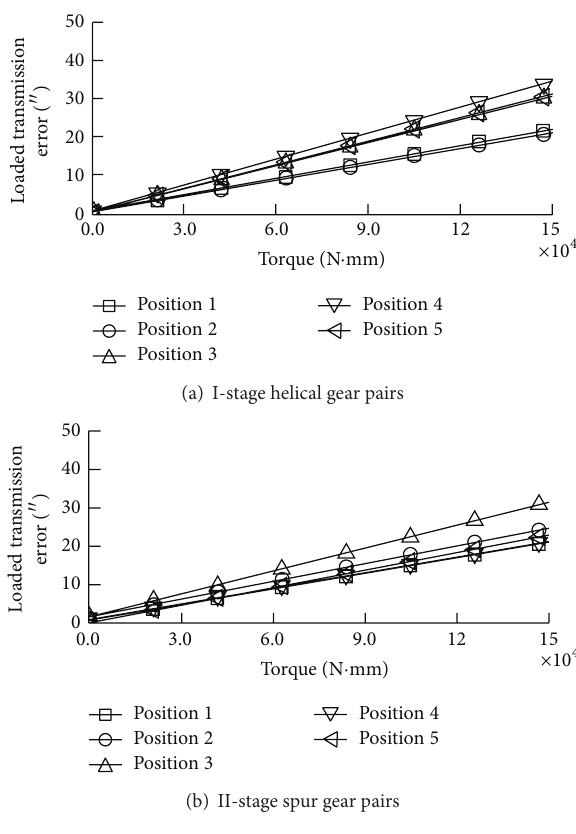
Figure 12: Loaded transmission errors.